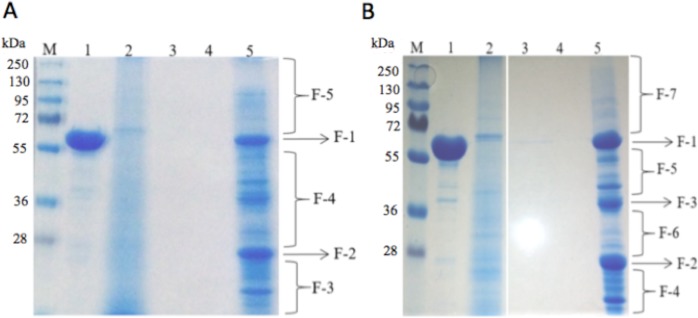
Pull down assays for identification of Cry1Ac-binding proteins in BBMV from second (Panel A) or fifth (Panel B) H. armigera larval instar. Proteins were resolved in SDS-PAGE. M, molecular marker; lanes 1, Cry1Ac toxin; lanes 2, soluble BBMV proteins from H. armigera; lanes 3 and 4, proteins found in the elution obtained after first and last wash with phosphate-buffer saline (PBS); lanes 5, BBMV proteins bound to CNBrCry1Ac. The lanes 5 containing the BBMV proteins bound to CNBr-Cry1Ac from second instar (panel A) or from fifth instar (panel B) were divided into five and seven fractions respectively. Each fraction was used for LC-MS/MS analysis.